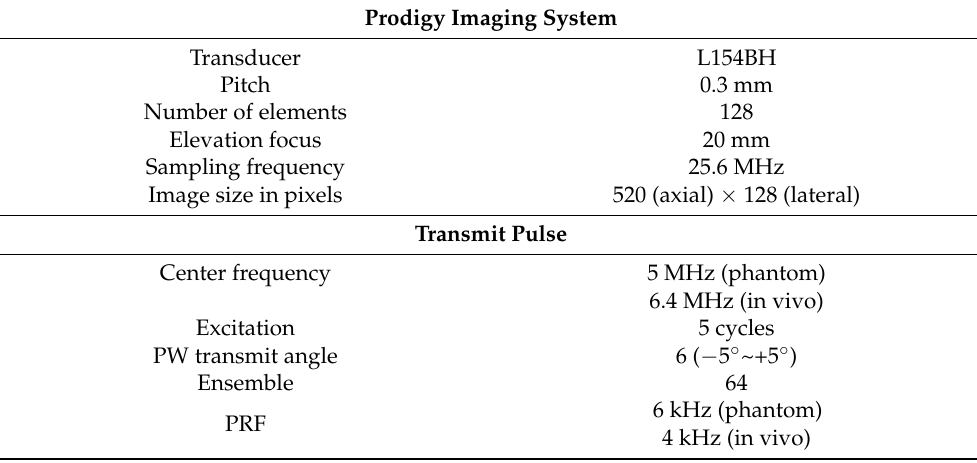
Table 2. Imaging parameters in phantom and in vivo